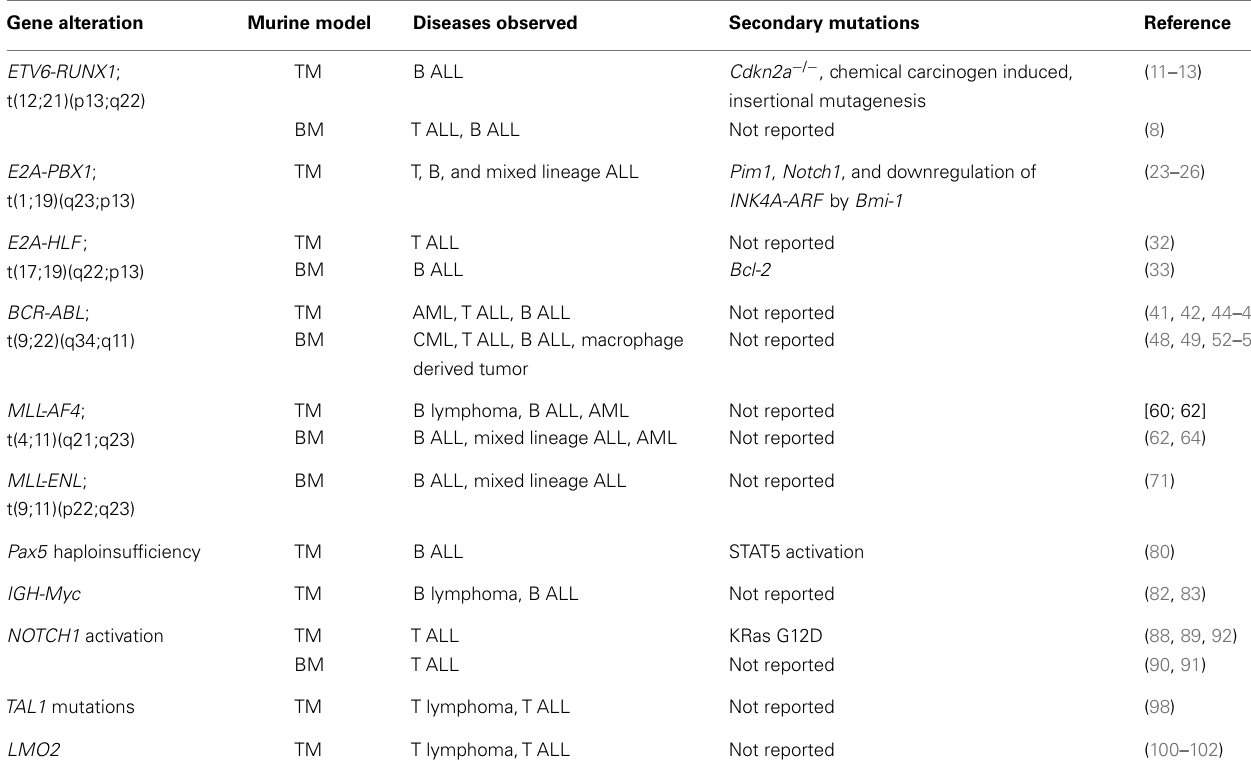
Table 1 | Syngeneic mouse models ofALL